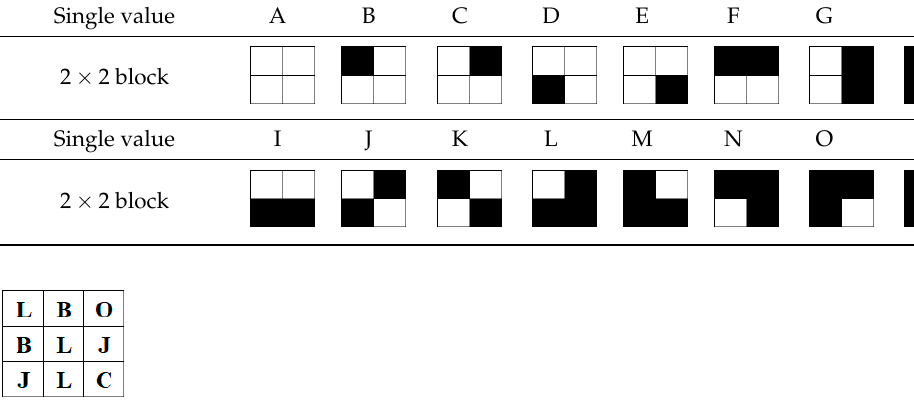
Figure 4. Result of block division and single-value replacement of the copyright watermark data.